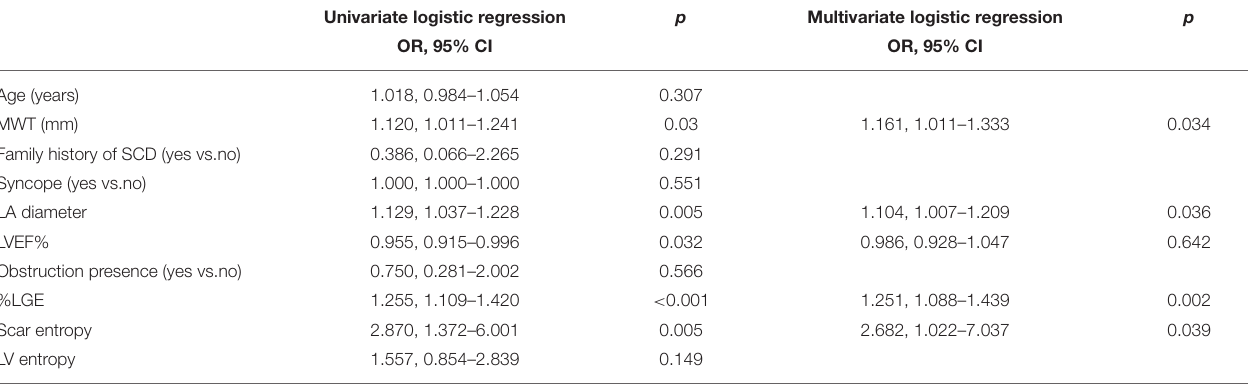
TABLE 2 | Univariate and multivariate logistic regression analyses for predictors of ventricular arrhythmia in HCM patients with LGE-CMR. Univariate logistic regression p Multivariate logistic